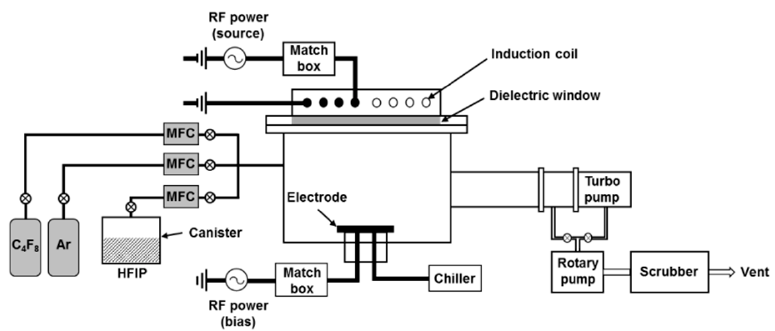
Figure 1. Schematic of an inductively coupled plasma apparatus.